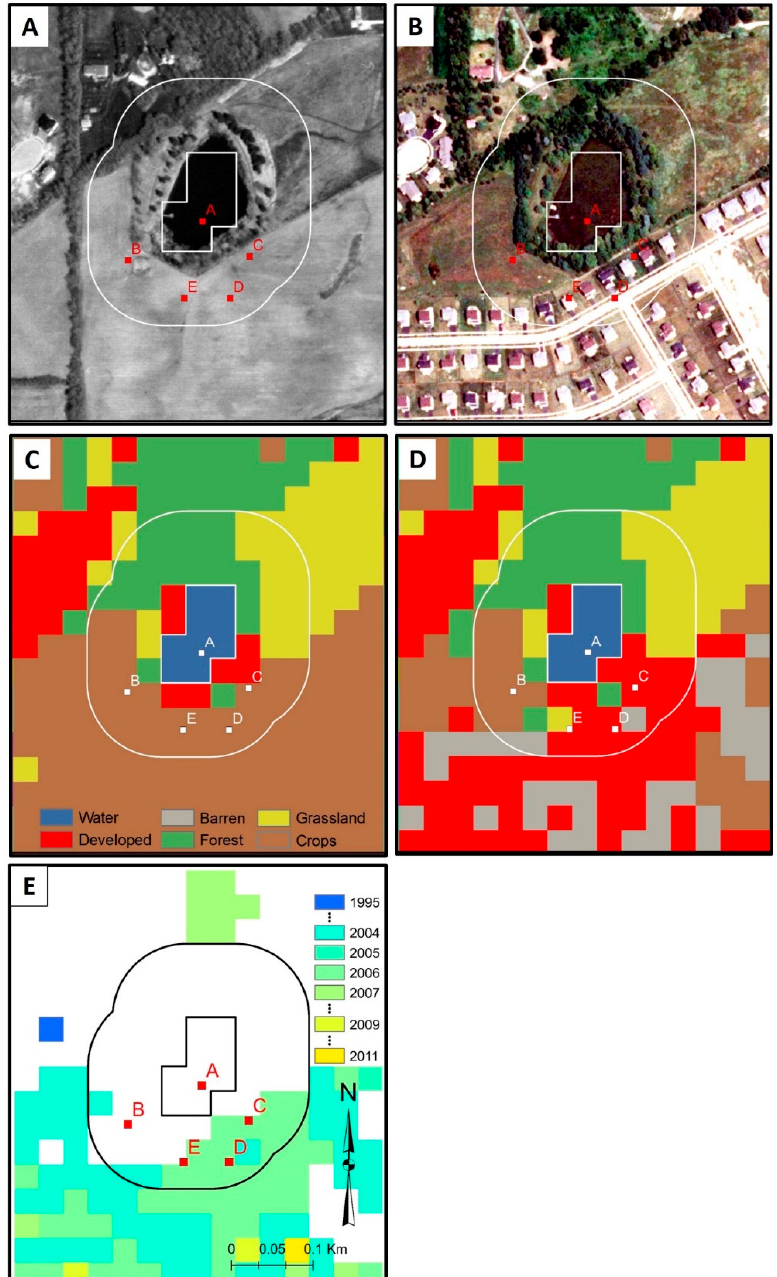
Figure 6. LULC change within a 90 m water body buffer, ( A ) aerial photo of surface water in Yorkville, IL dated 05 April 1998, ( B ) aerial photo from 06 August 2009 after significant development, ( C ) CCDC LULC classification of July 01, 1998, ( D ) CCDC LULC classification of 01 July 2009, ( E ) CCDC-informed year of change (see Figure 7 for further information on inset points A–E).